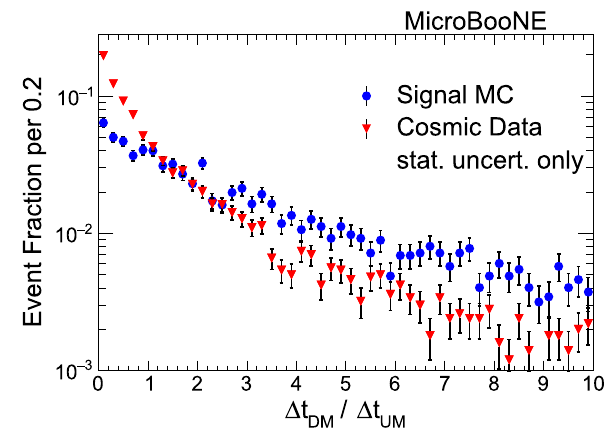
Fig. 5 Pulse height (PH) downstream to upstream ratio. Events with (cid:9) PH (cid:10) D